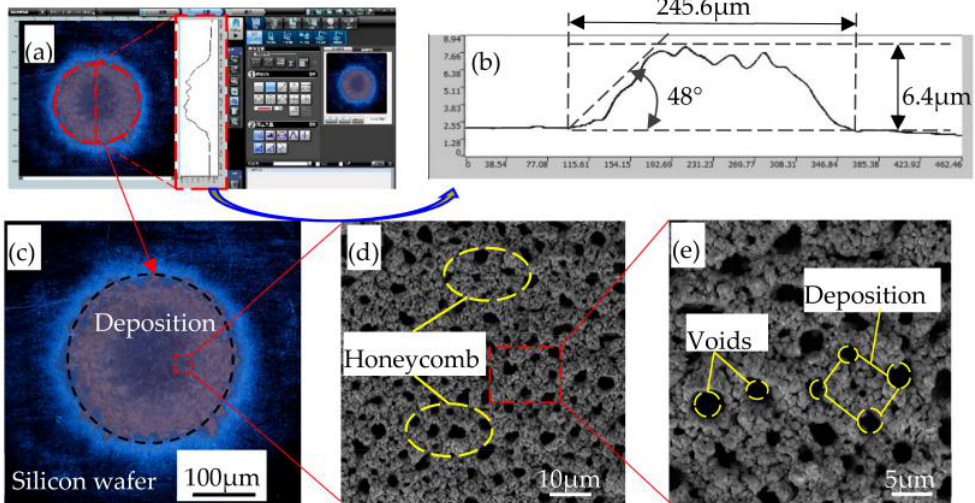
Figure 5. HV- µ EAM point ( a ) OLYMPUS microscope image of deposition point, ( b ) The image of deposition point contour scan, ( c ) Macroscopic image of HV- µ EAM point, ( d ) SEM image of deposition point 1000 × and ( e ) SEM image of deposition point 2000 ×